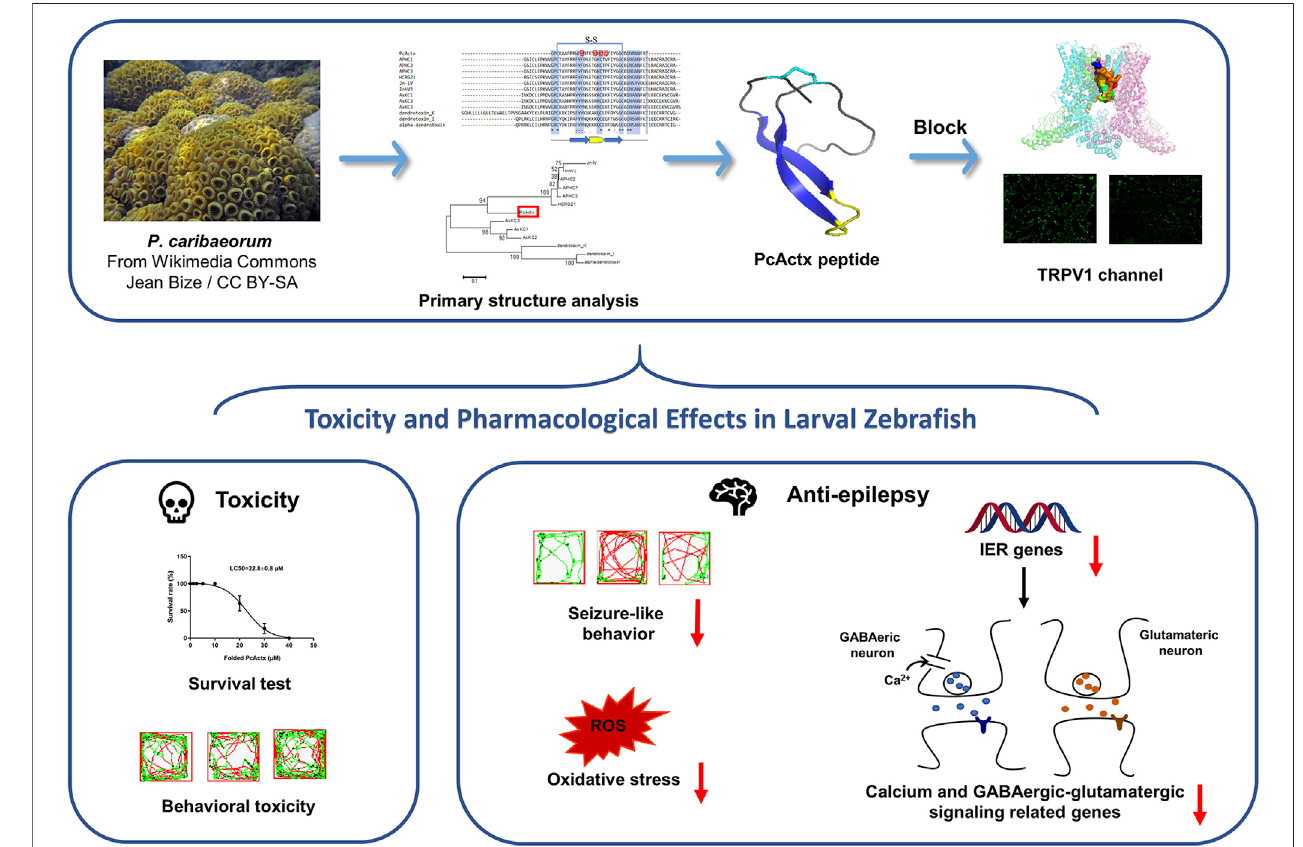
FIGURE 11 | A schematic diagram. PcActx peptide from transcriptome of zoantharian P. caribaeorum exhibits prominent anti-epileptic activity, probably through modulating calcium signaling and GABAergic-glutamatergic signaling.